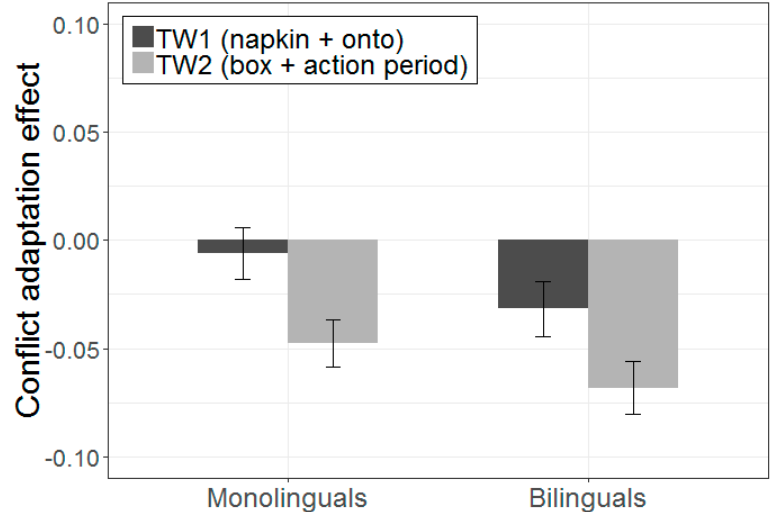
Figure 5. Effect of conflict adaptation (calculated as the difference between mean proportion of incongruent-ambiguous fixations and mean proportion of congruent-ambiguous fixations) for the incorrect goal during an early (TW1) and late (TW2) time window. More negative values on the y -axis indicate greater difference between incongruent-ambiguous and congruent-ambiguous sequences and, therefore, greater facilitation from incongruent Stroop sequences. Error bars indicate standard error of the mean.